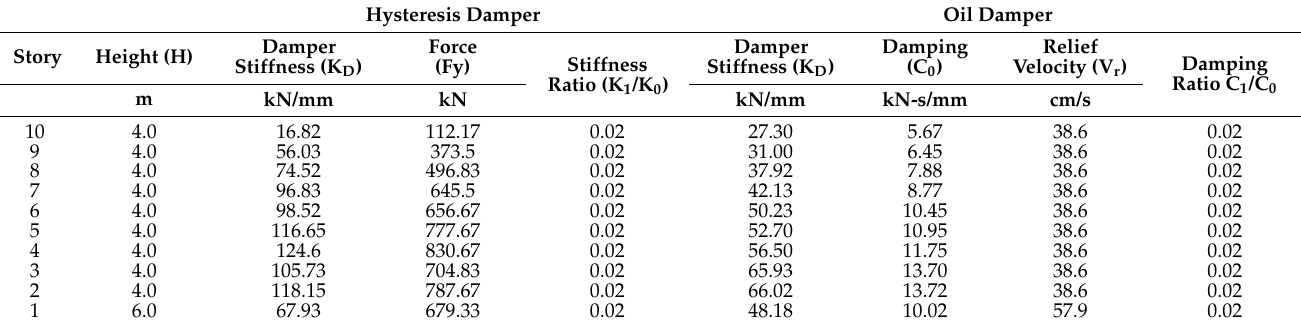
Table 4. Technical parameters of hysteresis and oil dampers.